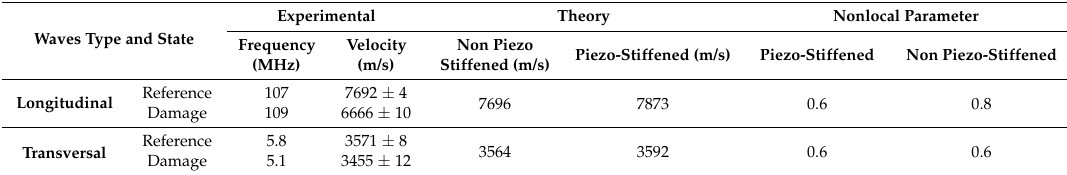
Table 2. Summary of the numerical and experimental